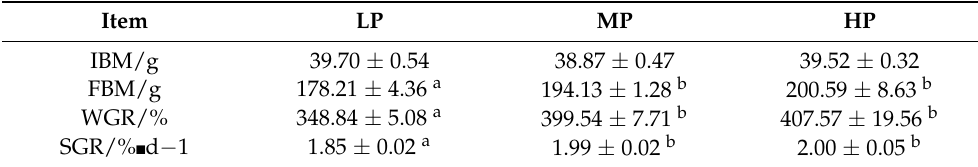
Table 3. Growth Performance of tilapia fed different test diets.